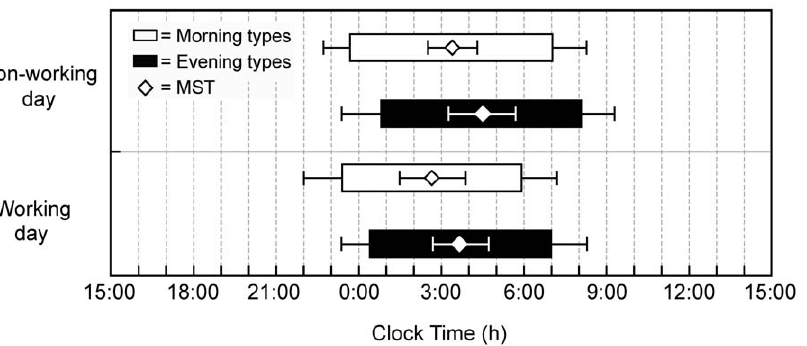
Figure 1. Sleep characteristics per chronotype. Horizontal bars represent sleep time as measured by actigraphy. Bedtime (mean 6 SD) and risetime (mean 6 SD) on all days combined and separately on non-working days and on work days in Morning (grey bars) and Evening types (black bars). The mid-sleep times (MSTs) (mean 6 SD) are depicted by open diamonds and compared between chronotypes by t -tests.